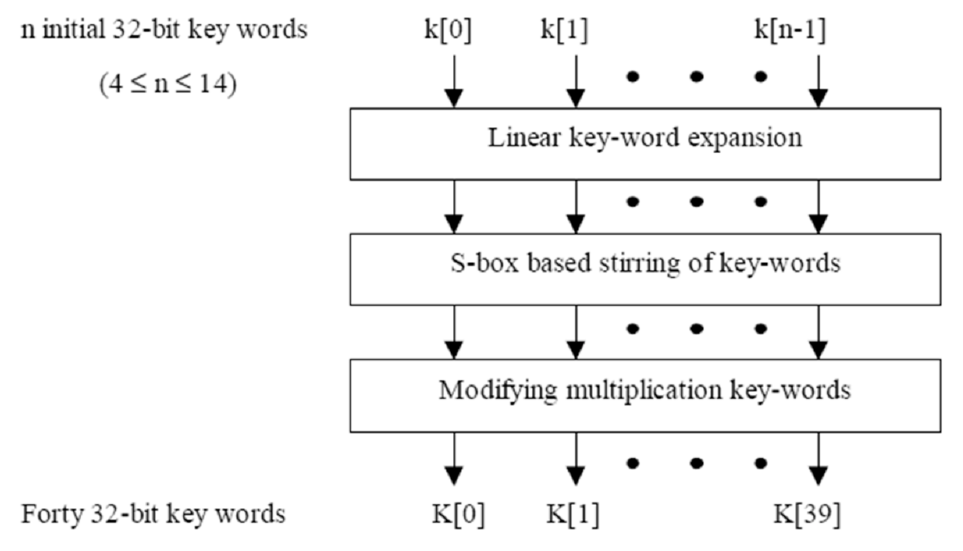
Figure 2. MARS’ key expansion